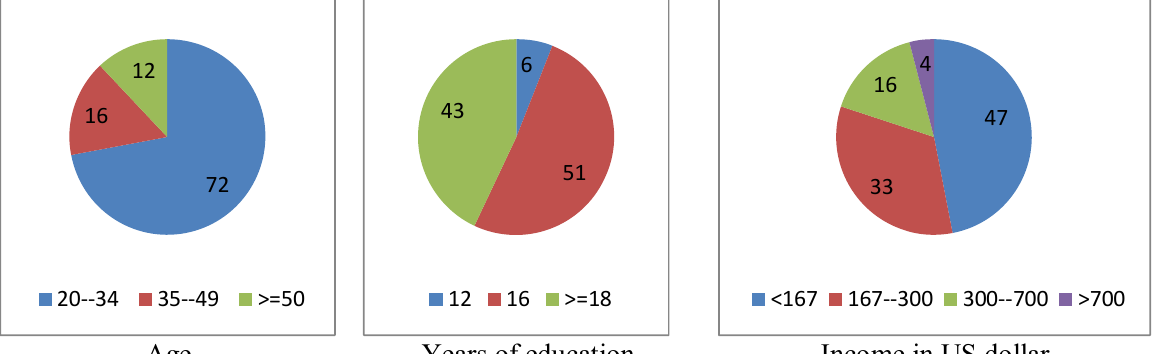
Fig. 2. Personal characteristics of the